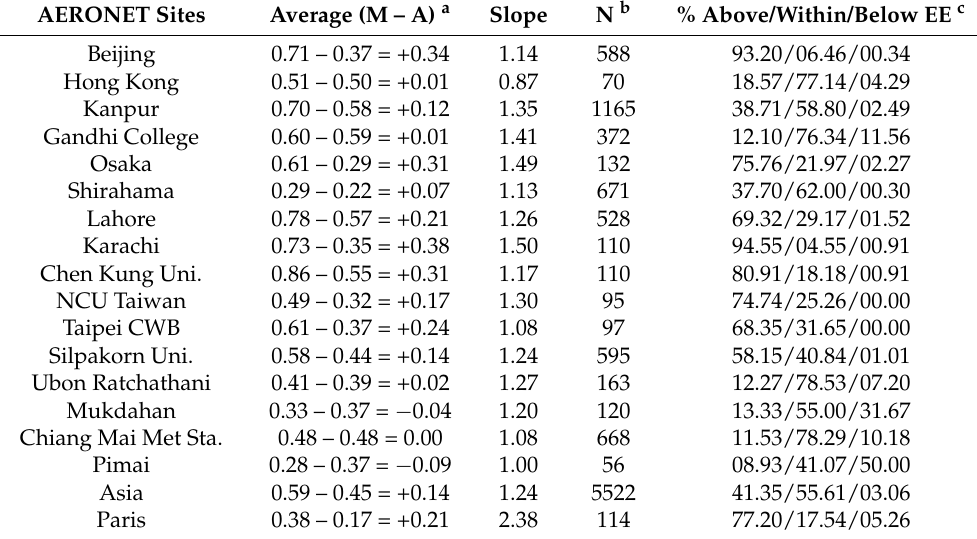
Table 2. Statistical summary for validation of MYD04_3K AOD observations over Asia. AERONET